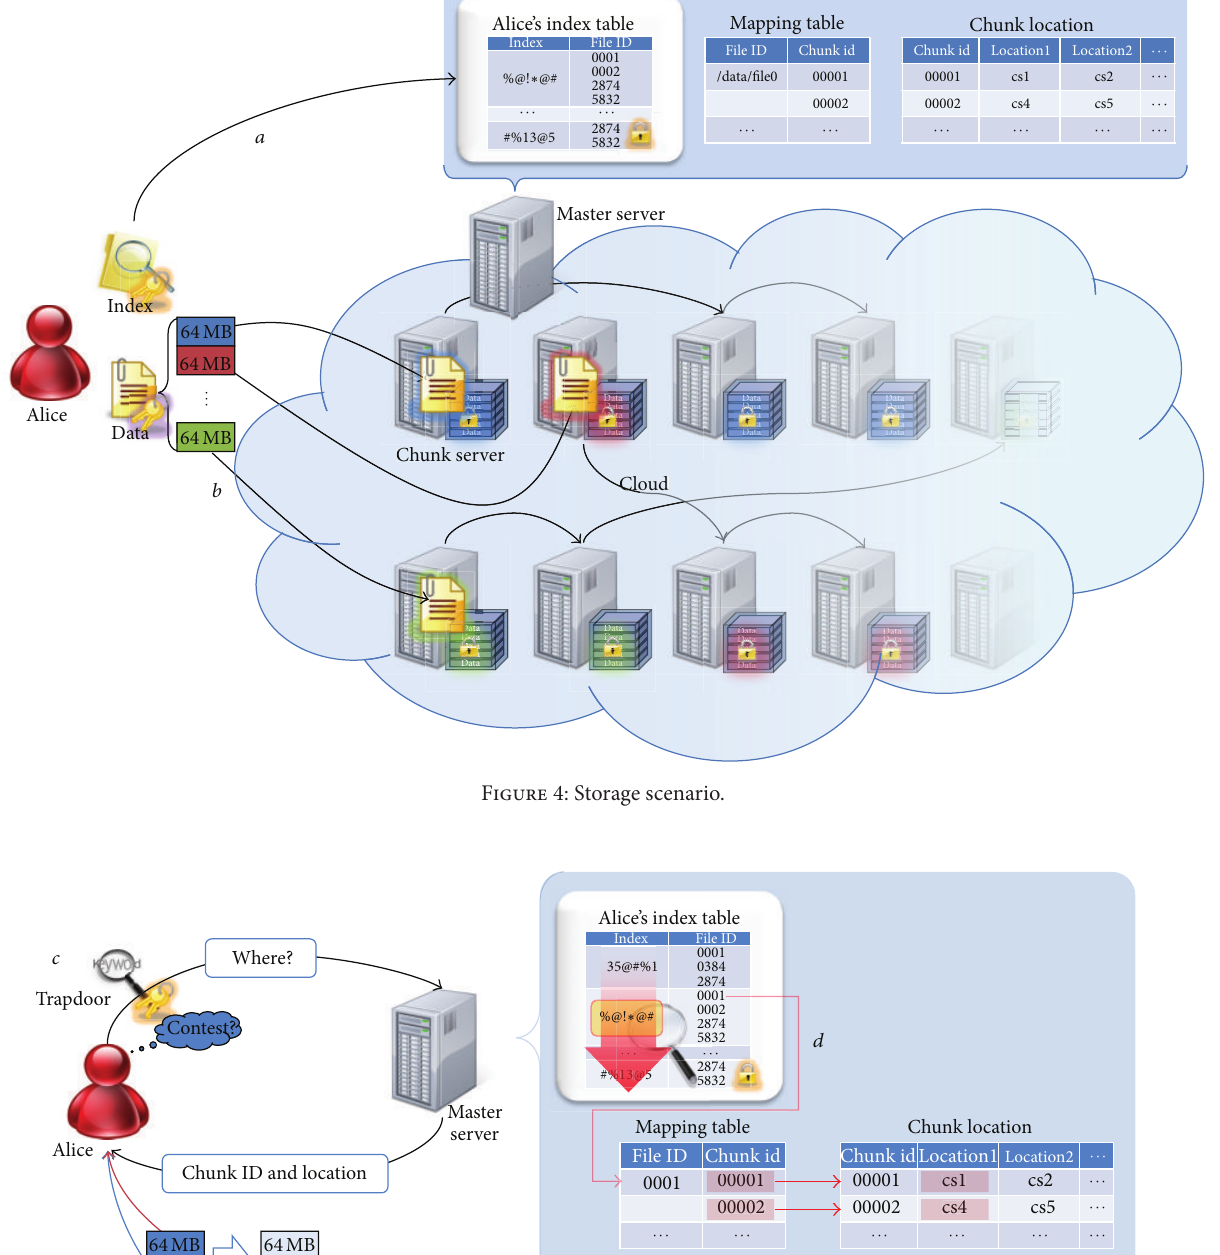
Figure 5: Search